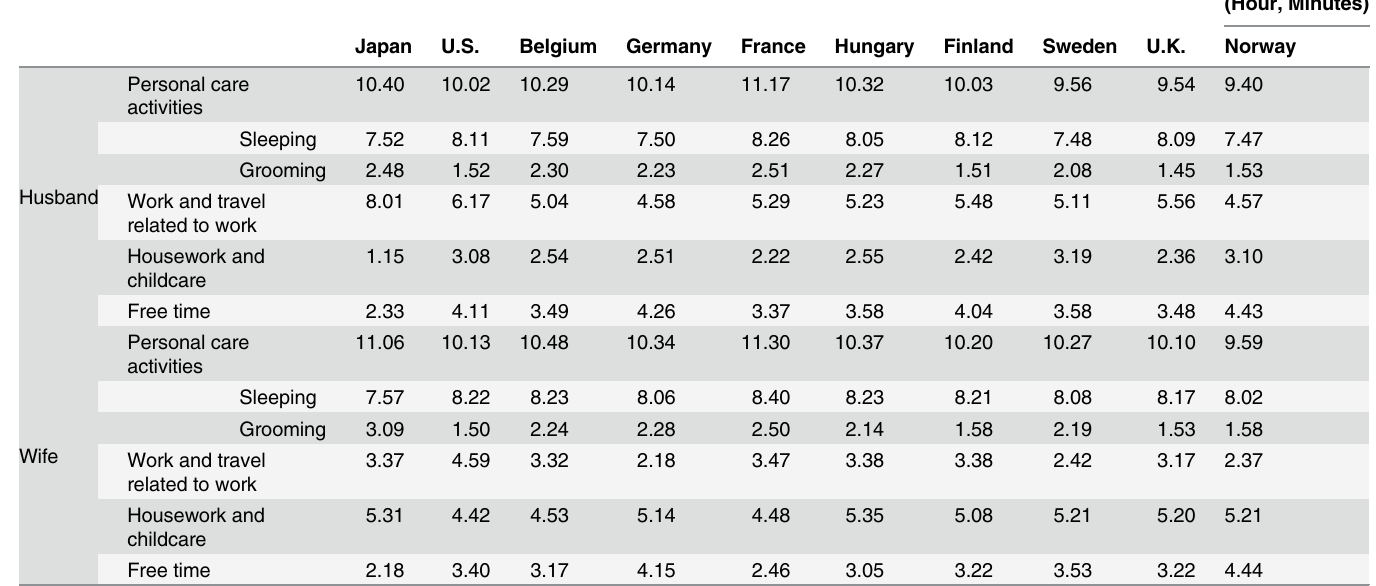
Table 1. Average Time Allocation among Various Activities – Whole Week, Working Husbands and Wives with Child(ren) under 6 (for Japan and the U.S., under 5) (hours.